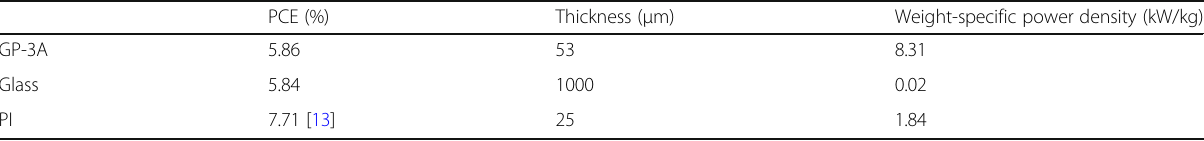
Table 1 Summary of power conversion efficiency (PCE), thickness and weight-specific power of a -Si:H solar cells based on GP-3A, glass and PI substrates